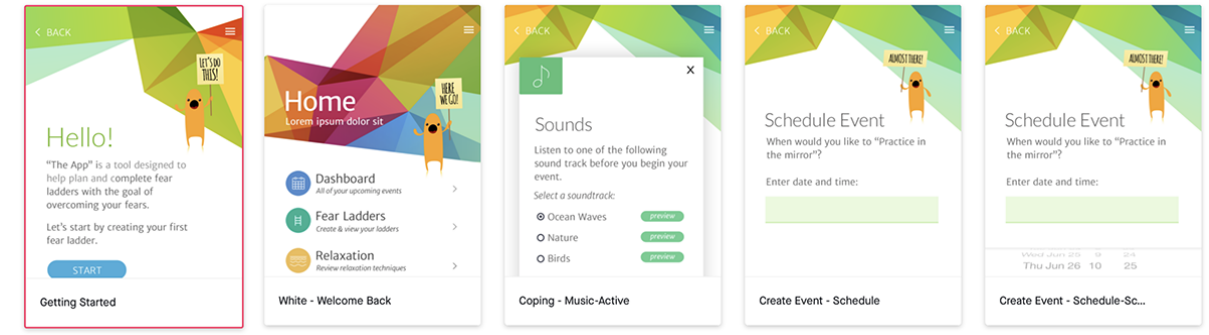
Figure 5. Screens from the low-fidelity MindClimb